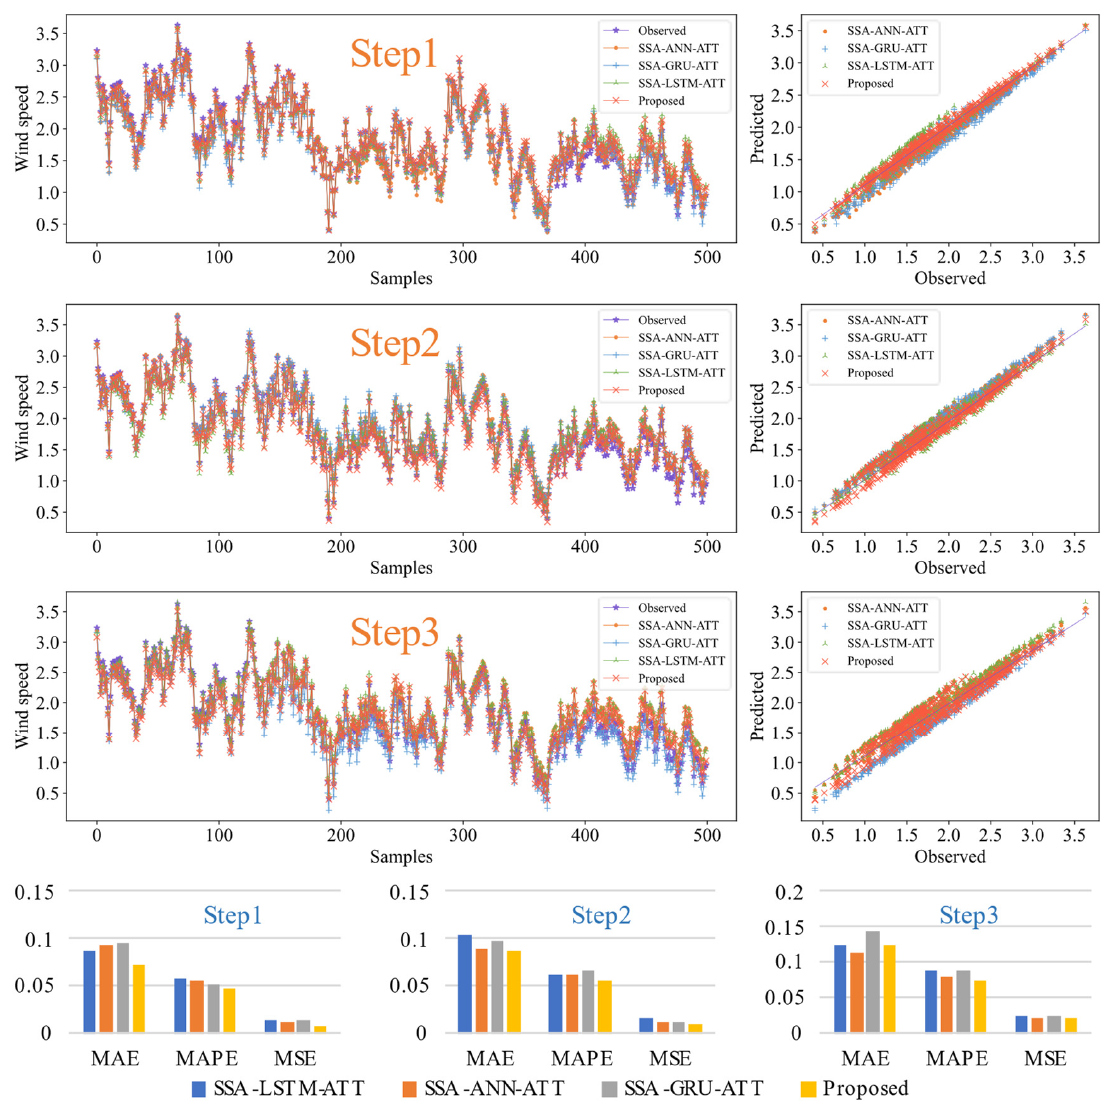
Figure 5. Forecasting results of models with different feature selection methods for dataset 1.